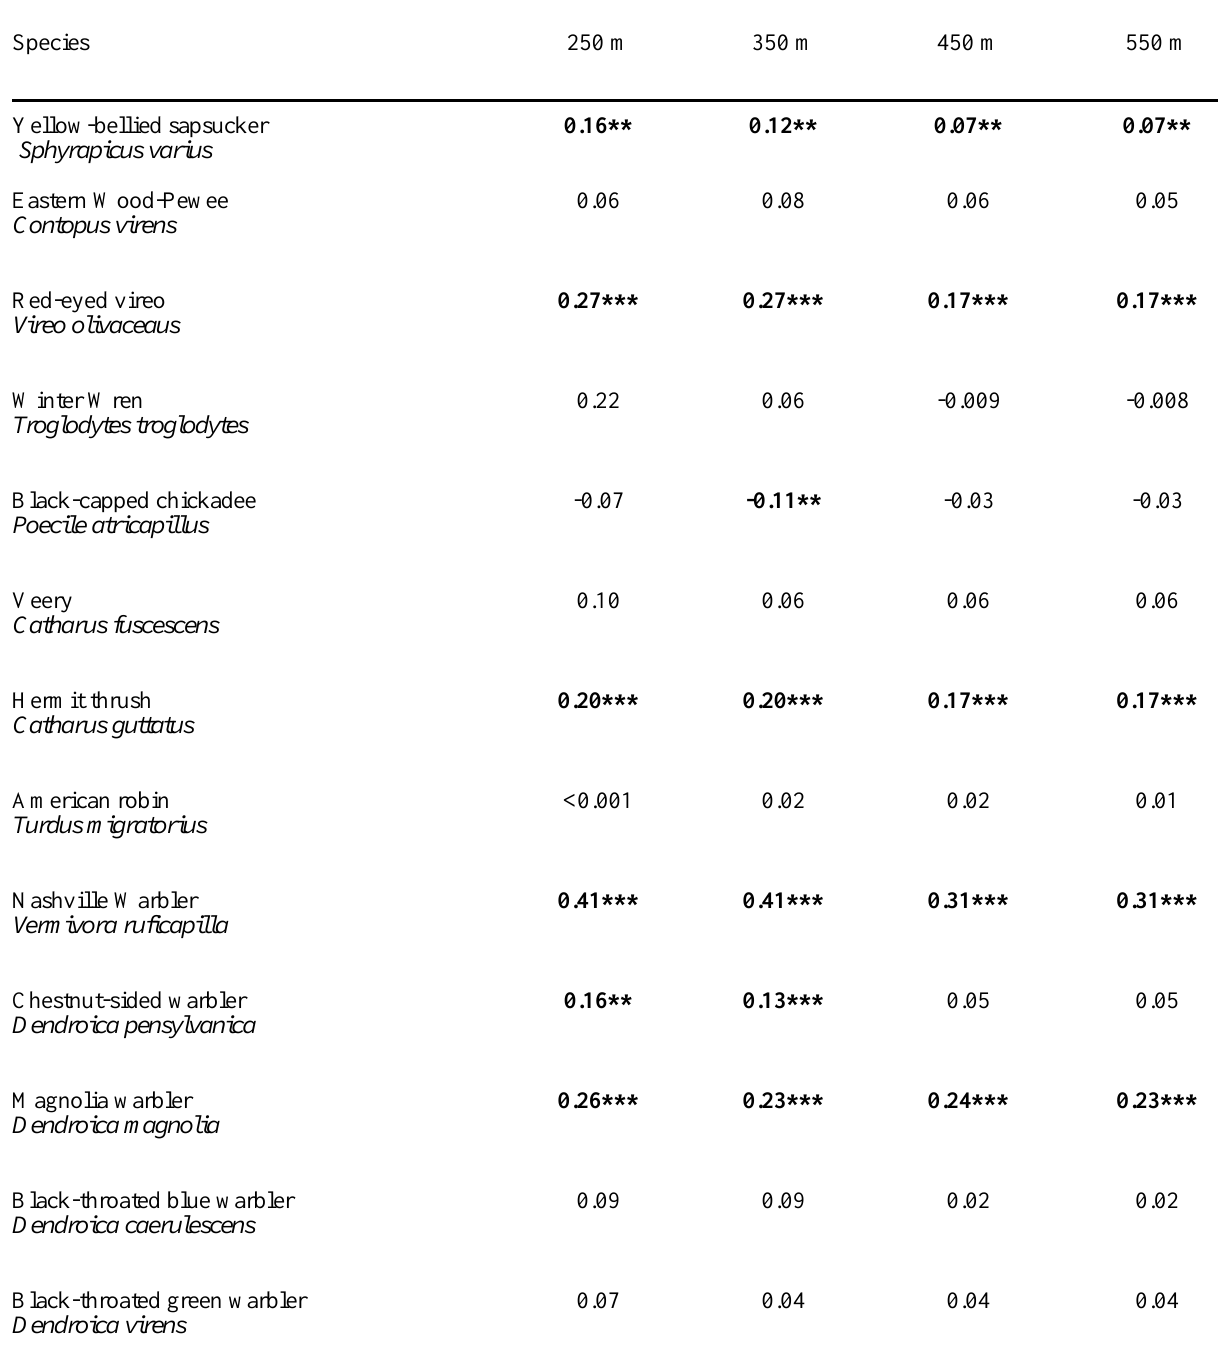
Table 1. Spatial autocorrelations of species occurrence as indicated by Moran’s I correlograms. Negative Moran’s I values indicate regular arrays, whereas positive values indicate clusters. Results of test: ** P <0.01, *** P